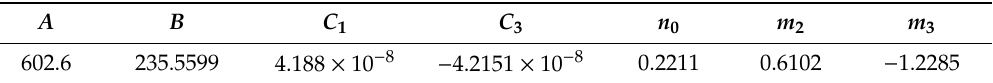
2.61%, respectively. Table 4. The optimized material constants of KL